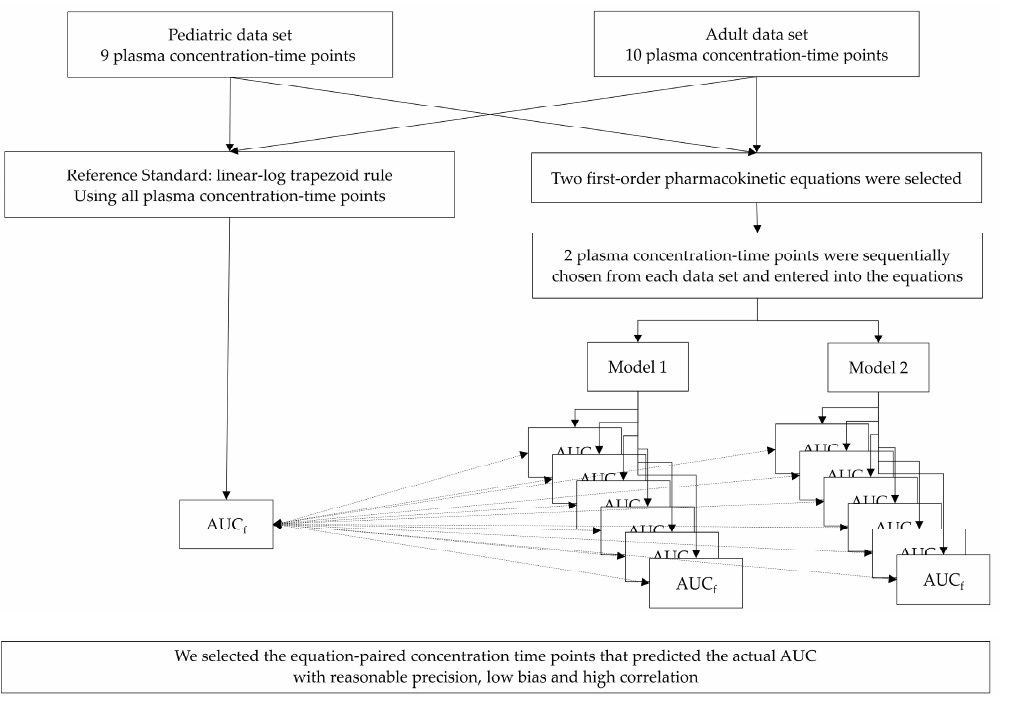
Figure 4. Study fl ow diagram. Abbreviations: AUC f , full area under the plasma concentration-time Figure 4. Study flow diagram. Abbreviations: AUC f , full area under the plasma concentration- curve. time